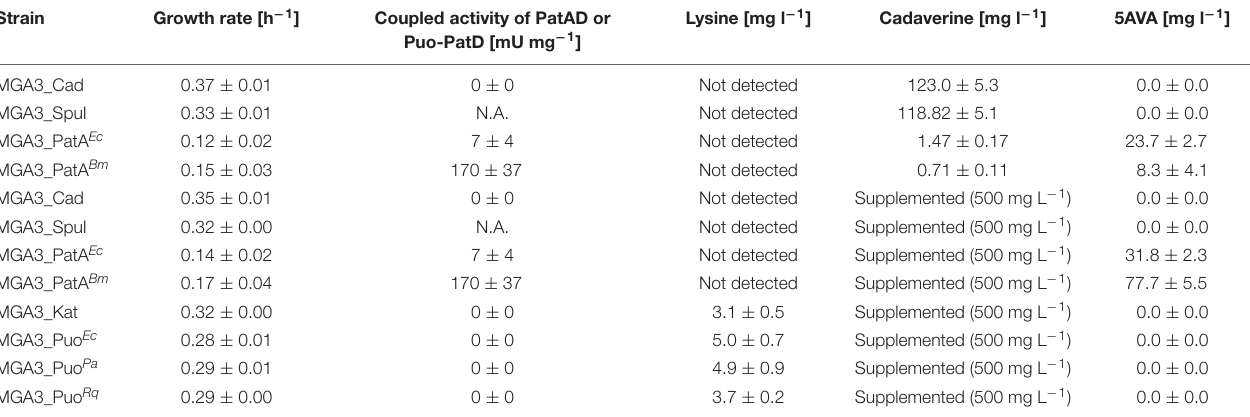
TABLE 5 | Growth rates, enzyme activities and L -lysine, cadaverine, and 5AVA final titers accumulated in growth media of recombinant MGA3 strains.